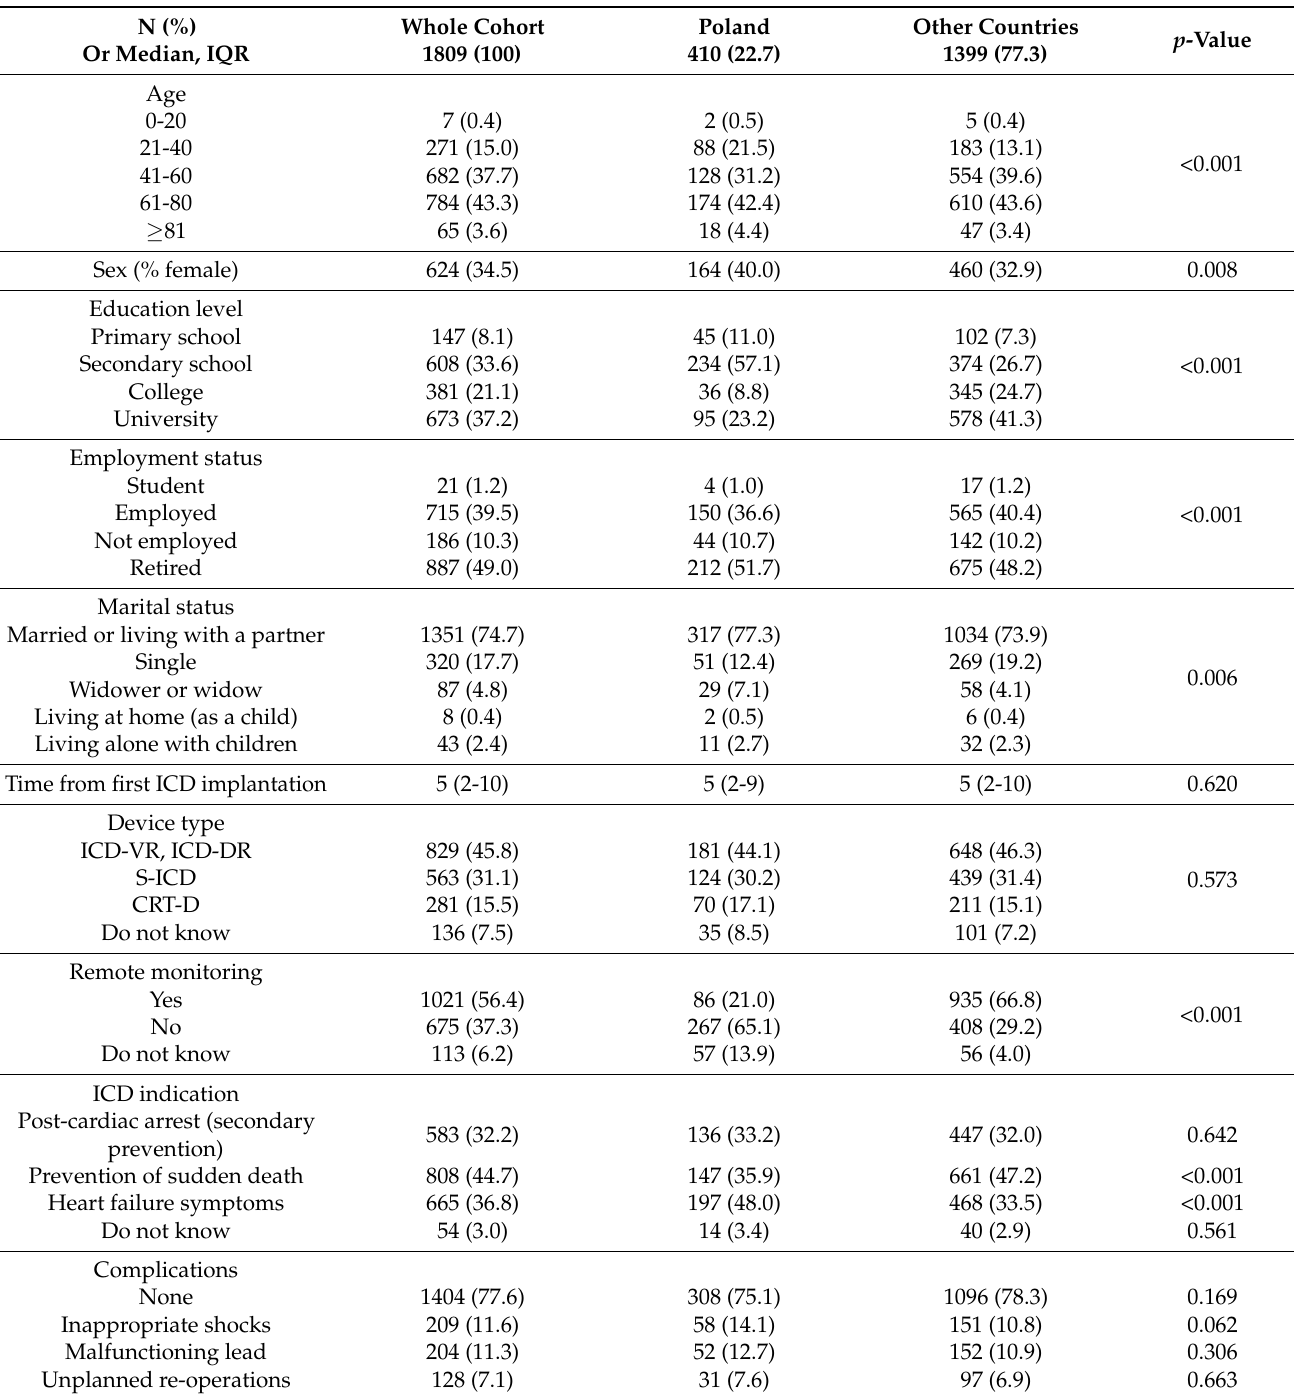
Table 1. Baseline characteristics according to